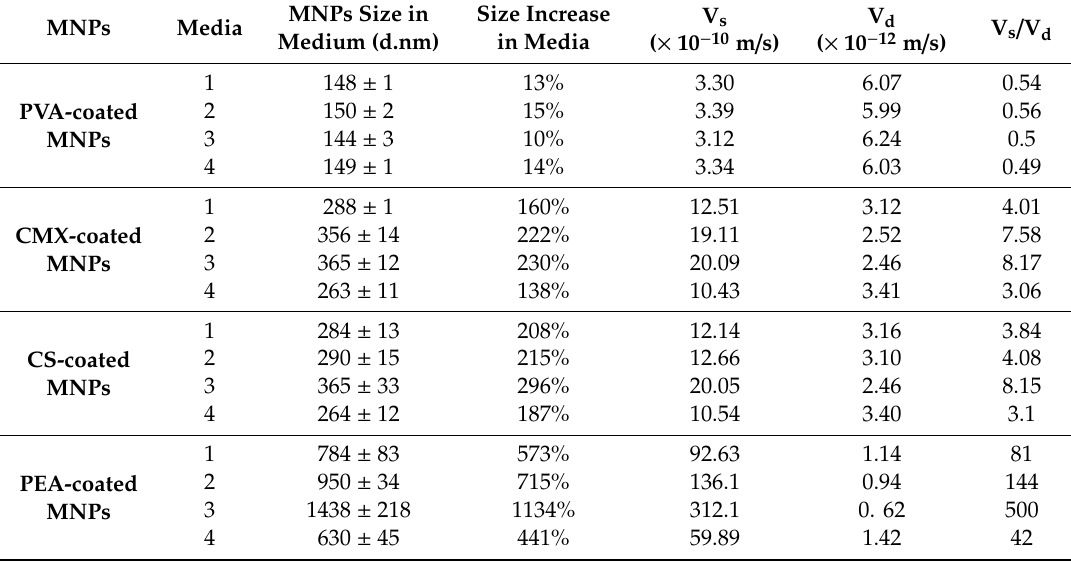
Table 5. V s and V d as well as the size of PVA-, CMX-, CS-, and PEA-coated MNPs in di ff erent culture media. See Table 2 for the components and concentrations of the media. Mean and standard deviation of the mean of MNPs size in media (n =